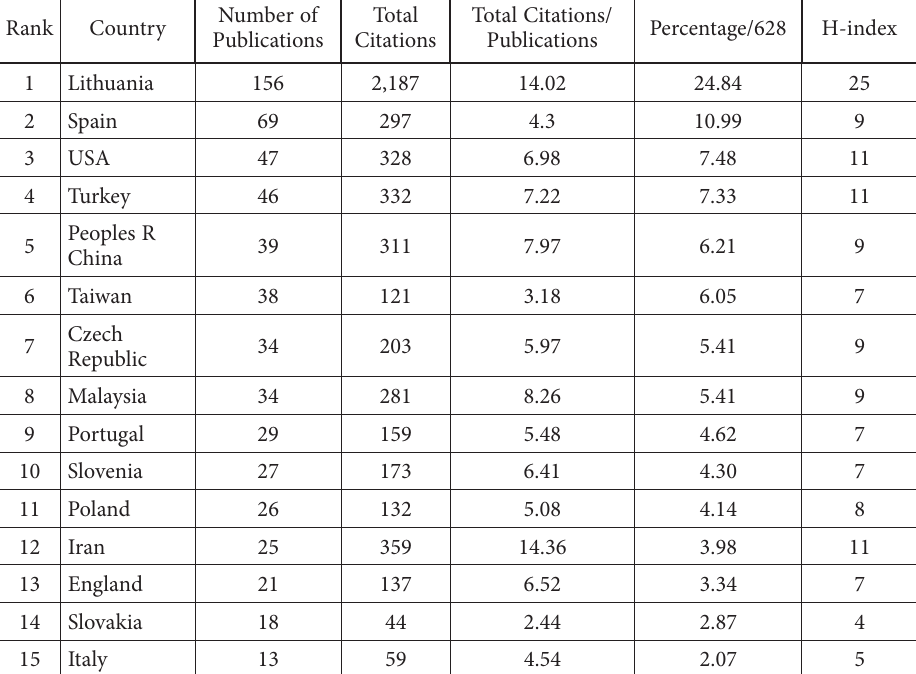
Table 3. Most productive countries (territories) of Journal of Business Economics and Management (JBEM) publications (>10)